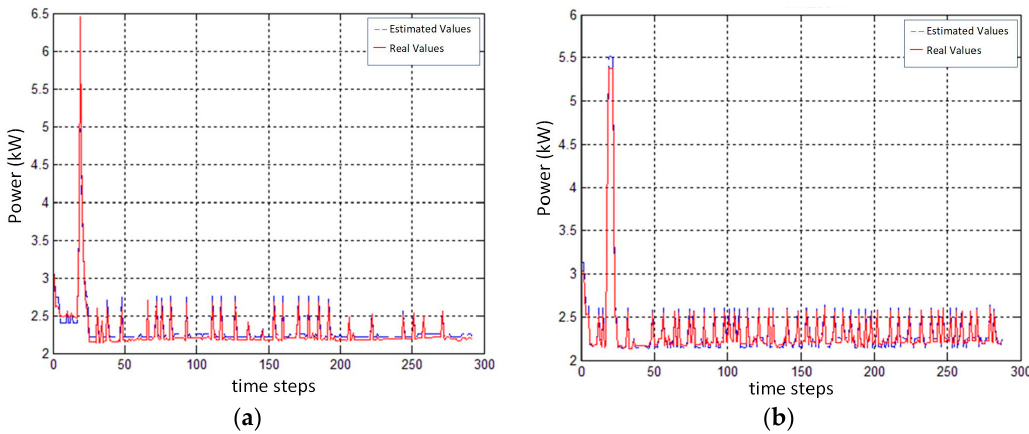
Figure 3. Comparison of chiller power consumptions between estimated and real values for ( a ) chiller 1; ( b ) chiller 2.